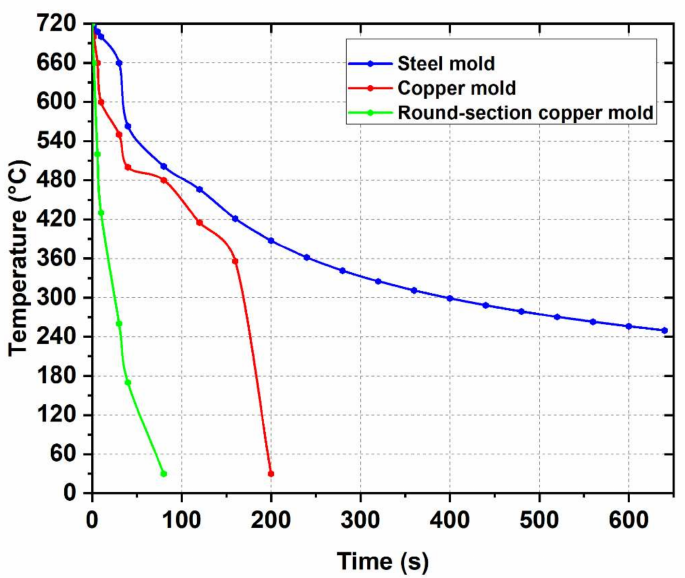
Figure 1. Temperature depending on time for different chill